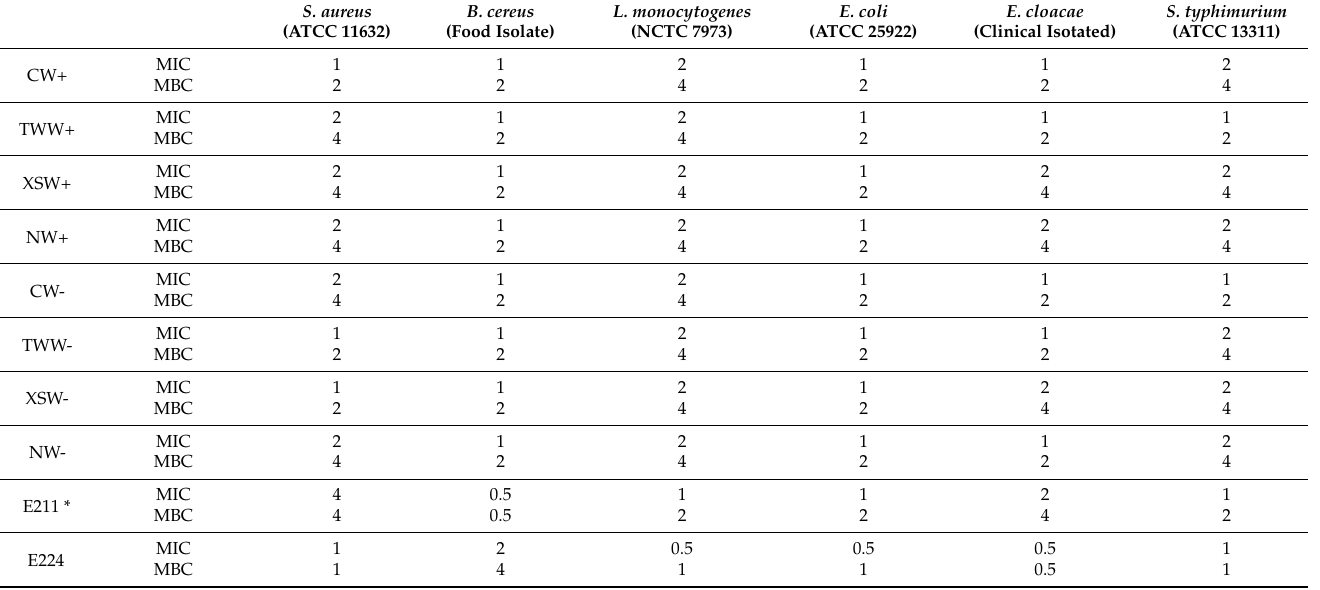
Table 5. Antibacterial activity (minimal inhibition concentration (MIC) and minimal bactericidal concentration (MBC), mg/mL) of tomato fruit hydroethanolic extracts in relation to irrigation regime and biostimulant